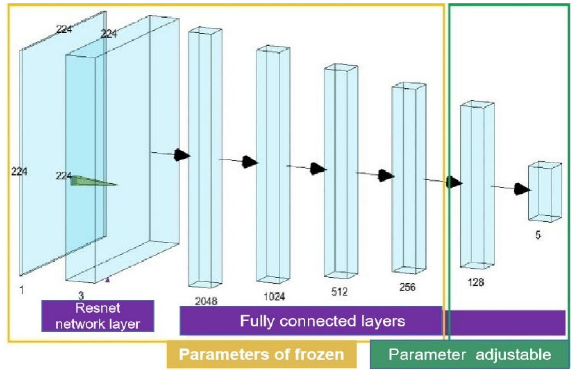
Figure 7. Multi ‐ machine learning model architecture. Figure 7. Multi-machine learning model architecture.